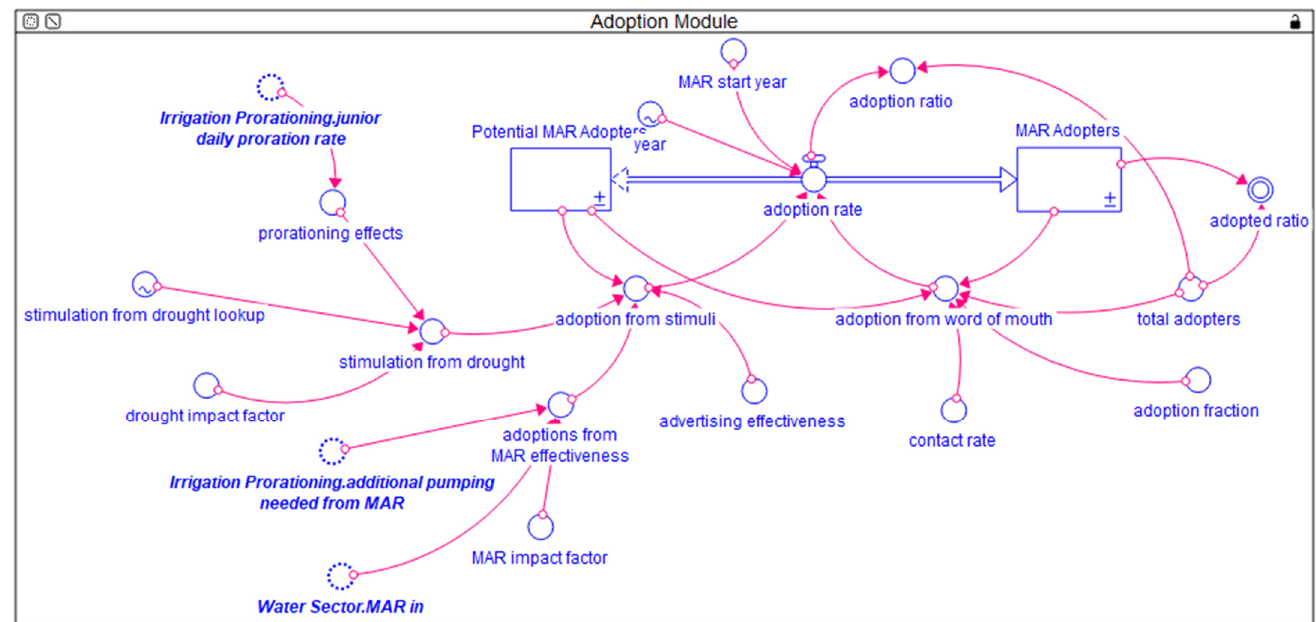
Figure A8. System dynamics model structure MAR adoption module.